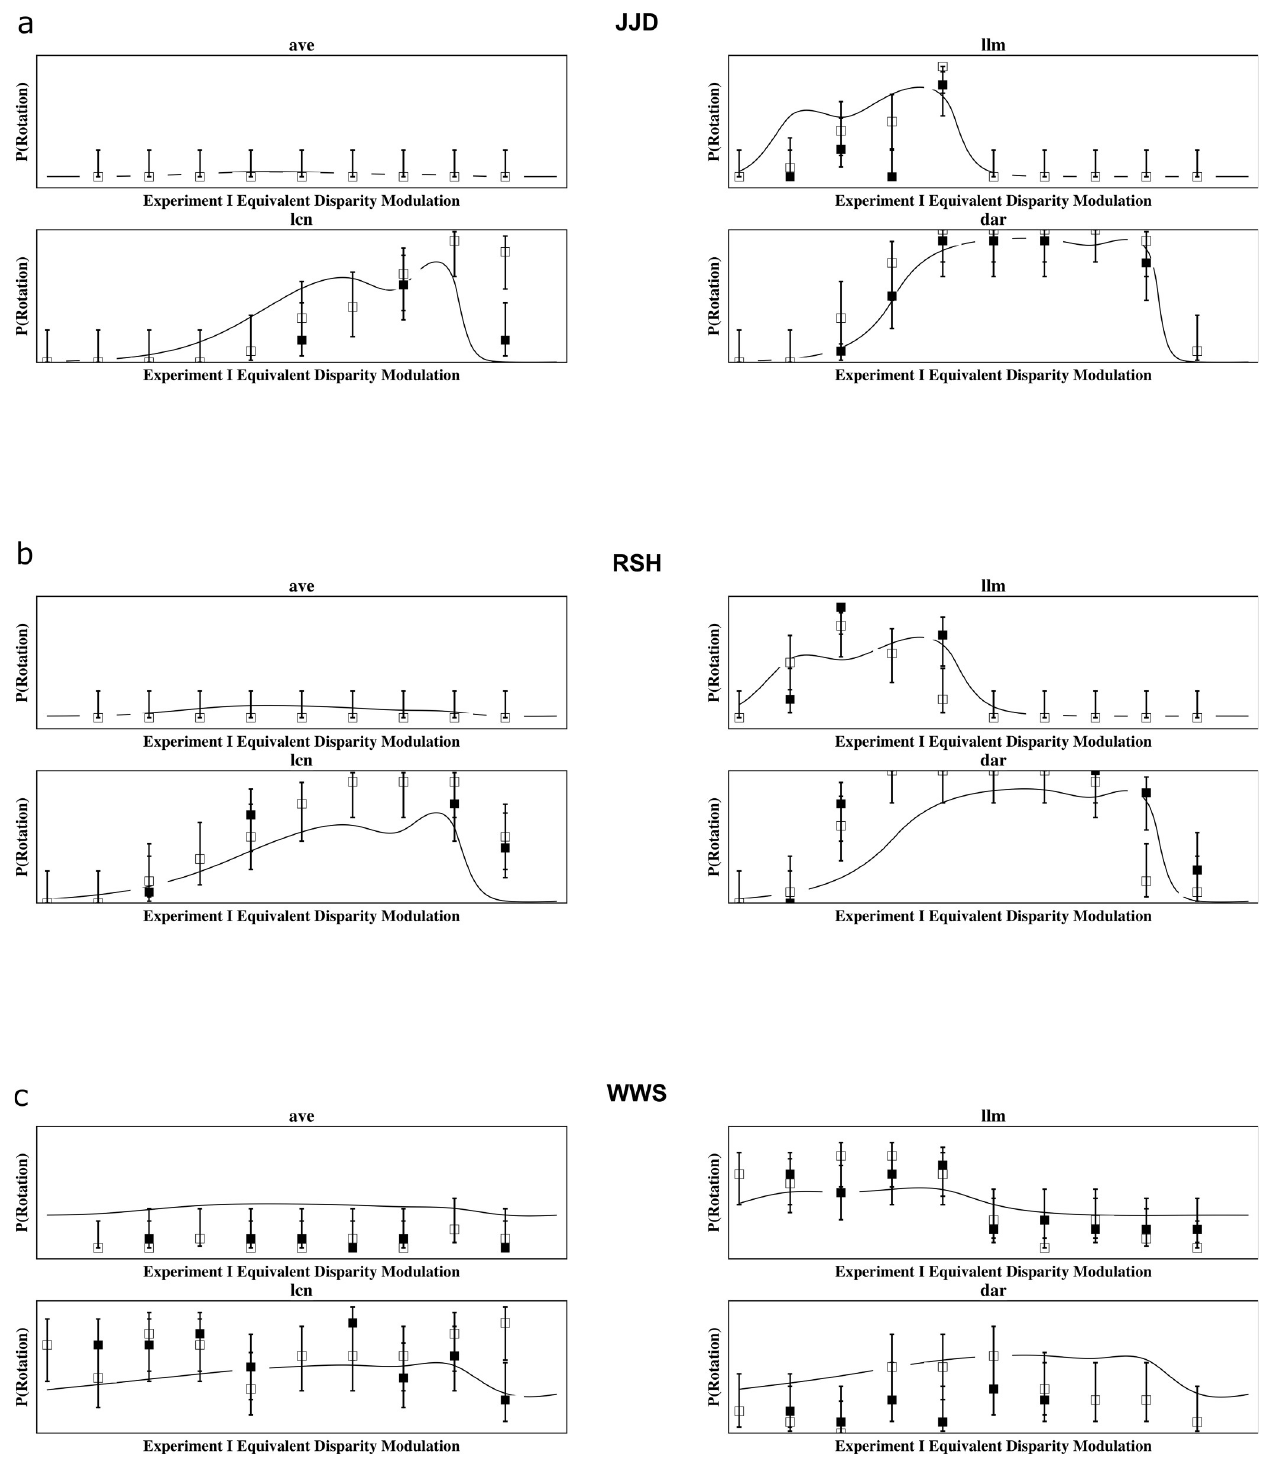
Fig 7. Model Predictions for perceived rotation. Predictions of the probability of perceiving rotation by the generalized difference model coupled with the presumed relationship of average luminance and contrast in controlling the response rate of neurons described by Eq (2) for participants (a) JJD, (b) RSH, and (c) WWS. The top left plot is for "average luminance" ("avg"), top right "light luminance bars" ("llm"), bottom left "light contrast bars" ("lcn"), and bottom right "dark bars" ("dar"). Probability of perceiving a rotation data are from the corresponding plots in Fig 6. Filled boxes are for the left "eye" condition and empty boxes for right "eye." Error bars indicate 95% confidence intervals based on the score estimator [60] (see also [61, 62]).